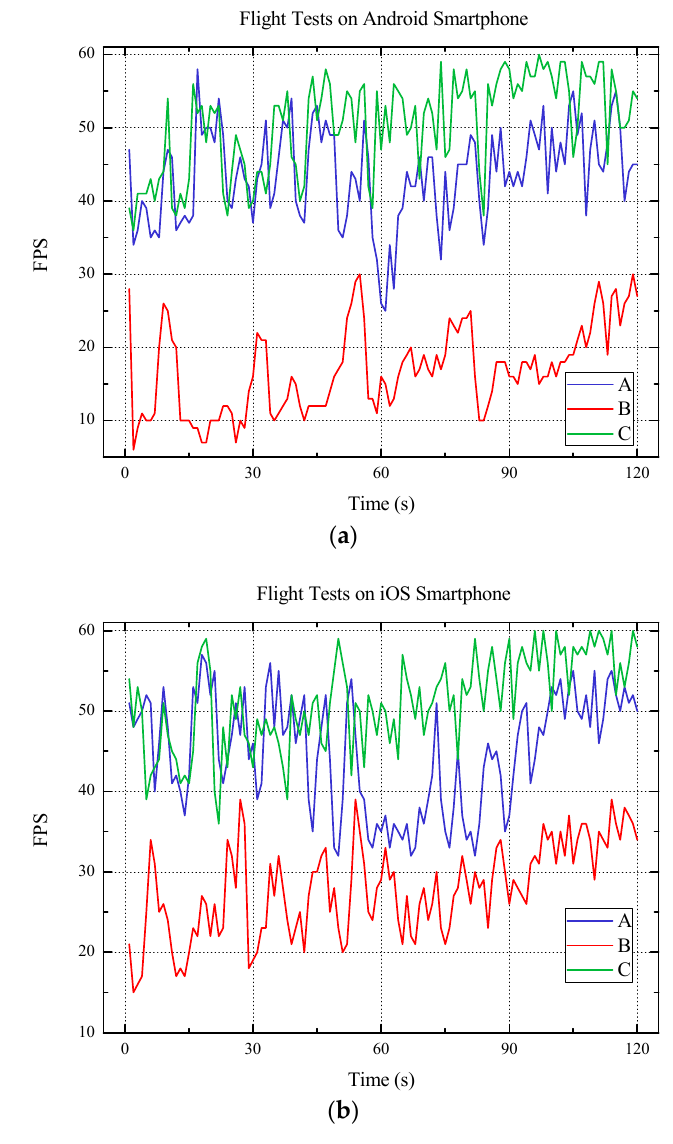
Figure 3. Tests of the influence of the loading different house models and flood routing models on the rendering frame rate: ( a ) flight tests on the Android smartphone; ( b ) flight tests on the iOS smartphone.